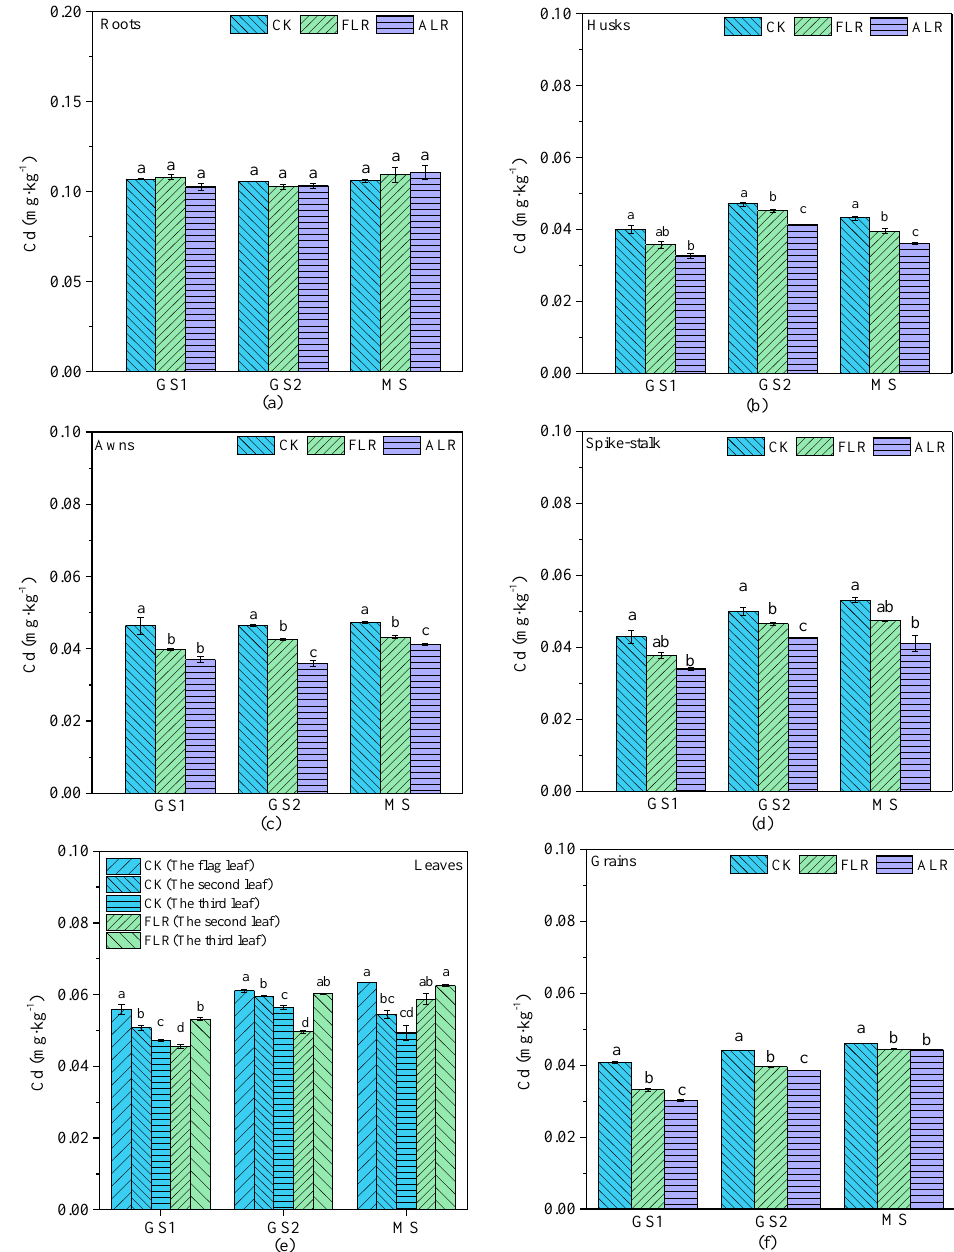
Figure 4. Cd concentration in wheat tissues in different grain filling stages. Note: Cd concentrations in roots ( a ), husks ( b ), awns ( c ), spike-stalk ( d ), leaves ( e ) and grains ( f ) under different treatments located at different stages. Different letters (a, b, c, d) indicate that there are significant differences in the same stage ( p < 0.05). The data are expressed as the means ± SD (n = 3); GS1 = early grain filling stage, GS2 = middle grain filling stage, MS = mature stage.